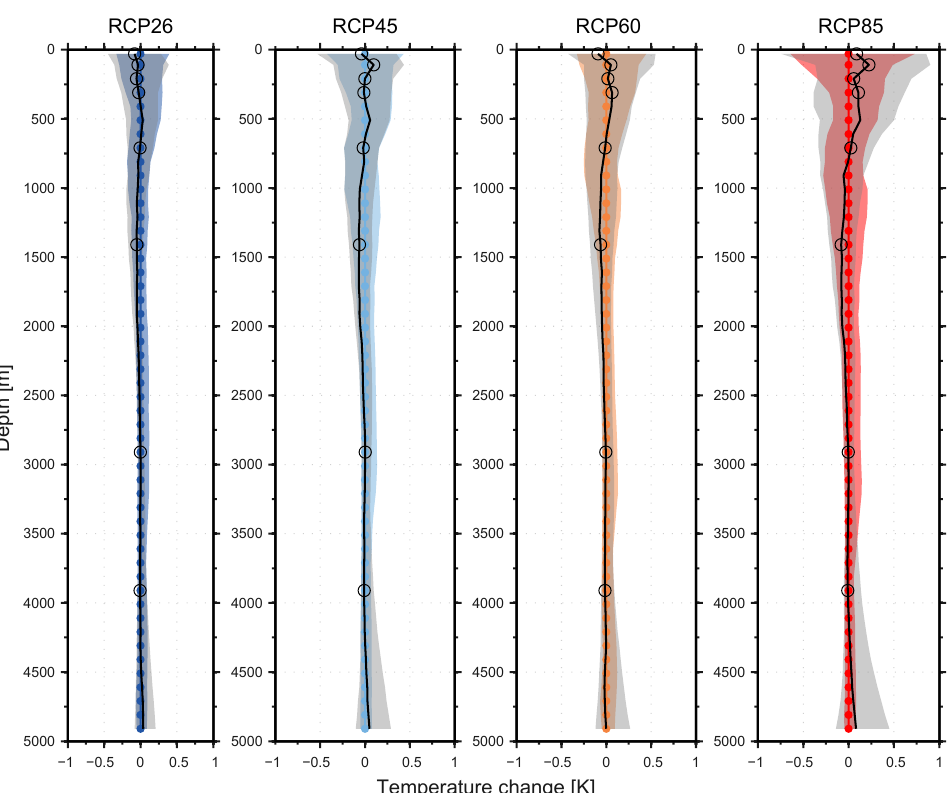
Figure A1. Potential ocean temperature residuals for calibrated MAGICC and reference CMIP5 ocean warming under RCP2.6, RCP4.5, RCP6.0, and RCP8.5 scenarios. Residuals are given with respect to the median CMIP5 2081–2100 to 1986–2005 anomalies for every MAGICC ocean layer. CMIP5 reference median and 90% range are shown in color, with circles indicating the individual MAGICC ocean layers. Calibrated MAGICC 90% model range and median residuals are provided as gray shadings and black lines with open circles indicating the selected layers for the ocean